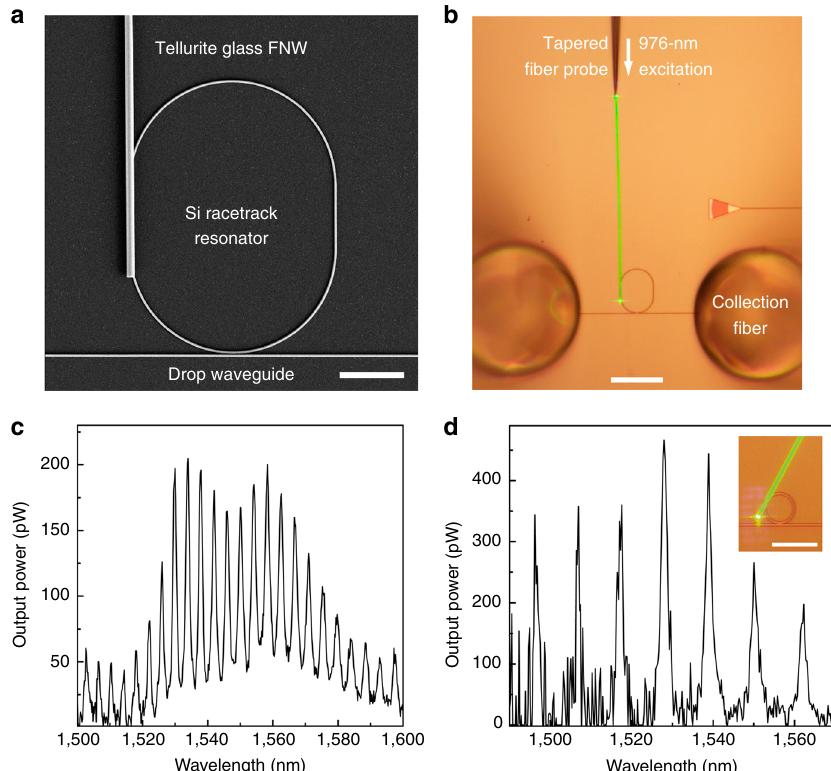
Fig. 4 Integrated FNW-SW-resonators for on-chip light generation. The active FNWs used here are Er 3+ /Yb 3+ -codoped tellurite glass nano fi bers. a SEM image of a 121- μ m-perimeter racetrack resonator integrated with a 193- μ m-length 980-nm-diameter tellurite glass FNW. Scale bar, 10 μ m. b Optical micrograph of the integrated FNW-SW-resonators under a 976-nm-wavelength excitation from a tapered fi ber probe. Green light observed on the excited FNW is attributed to the up-conversion luminescence of Er 3+ ions. Scale bar, 50 μ m. c Output signal collected in the drop waveguide of the racetrack resonator in b . d Output signal from a 50- μ m-perimeter SW resonator integrated with a 960-nm-diameter 216- μ m-length tellurite glass